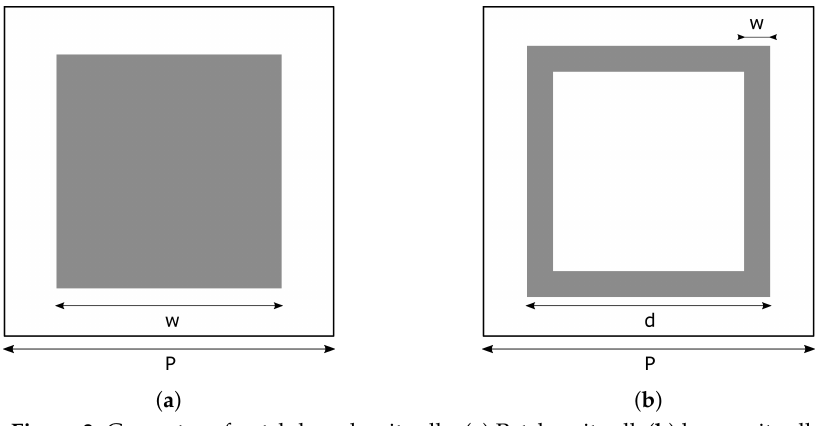
Figure 3. Geometry of patch-based unit cells. ( a ) Patch unit cell; ( b ) loop unit